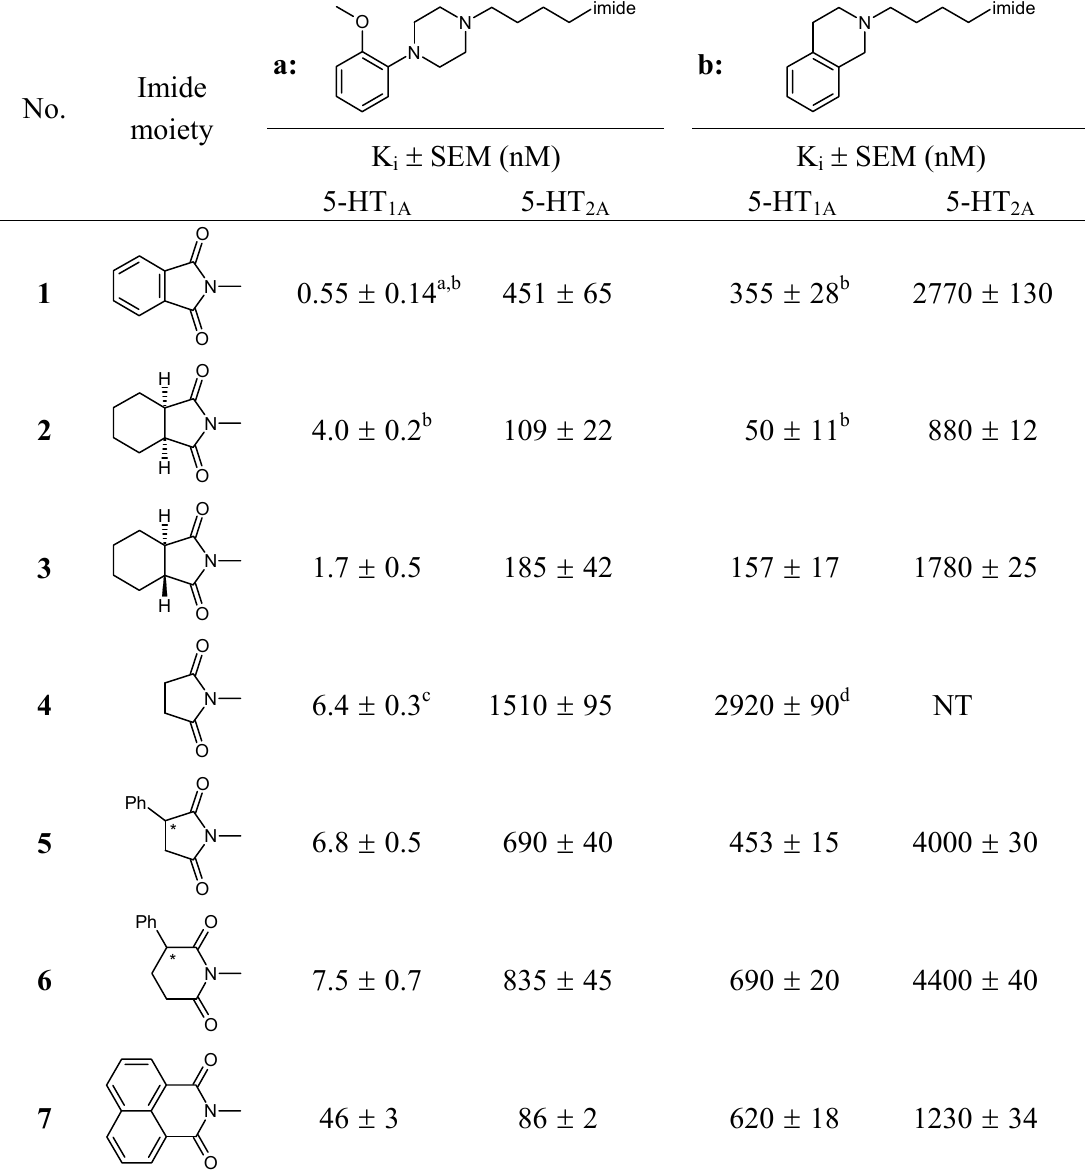
and 5-HT binding affinities of compounds 1 – 7 . 1A 2A imide NO a: N K ± SEM (nM) K i 5-HT 5-HT 1A 2A